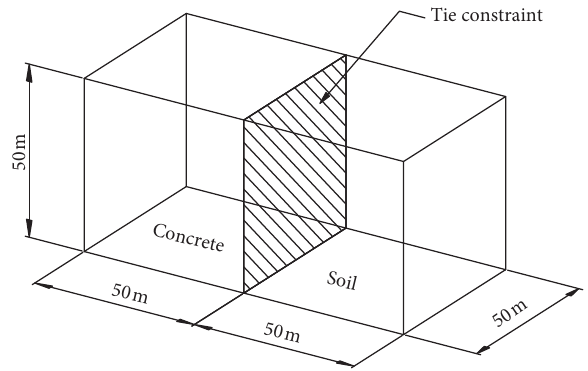
Figure 5: Dimensions of model 2. Table 3: Parameters of the materials in Model 2.